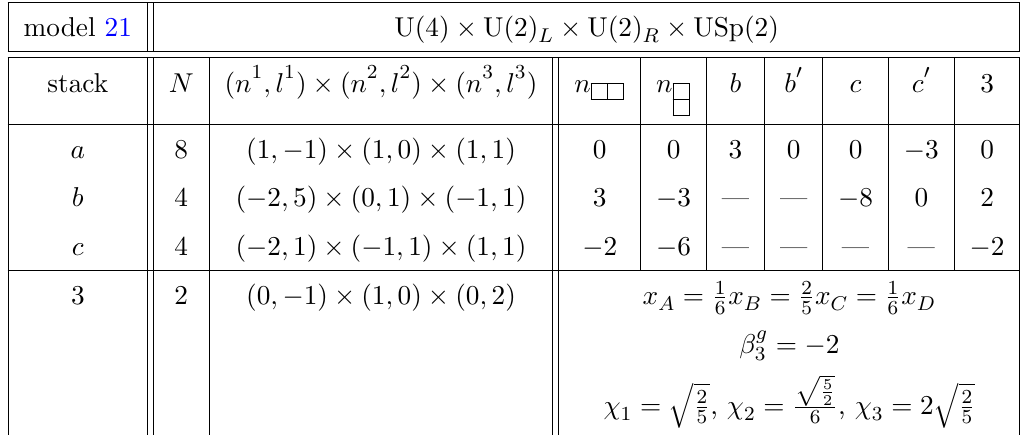
Table 21 . D6-brane configurations and intersection numbers of Model 21, and its MSSM gauge